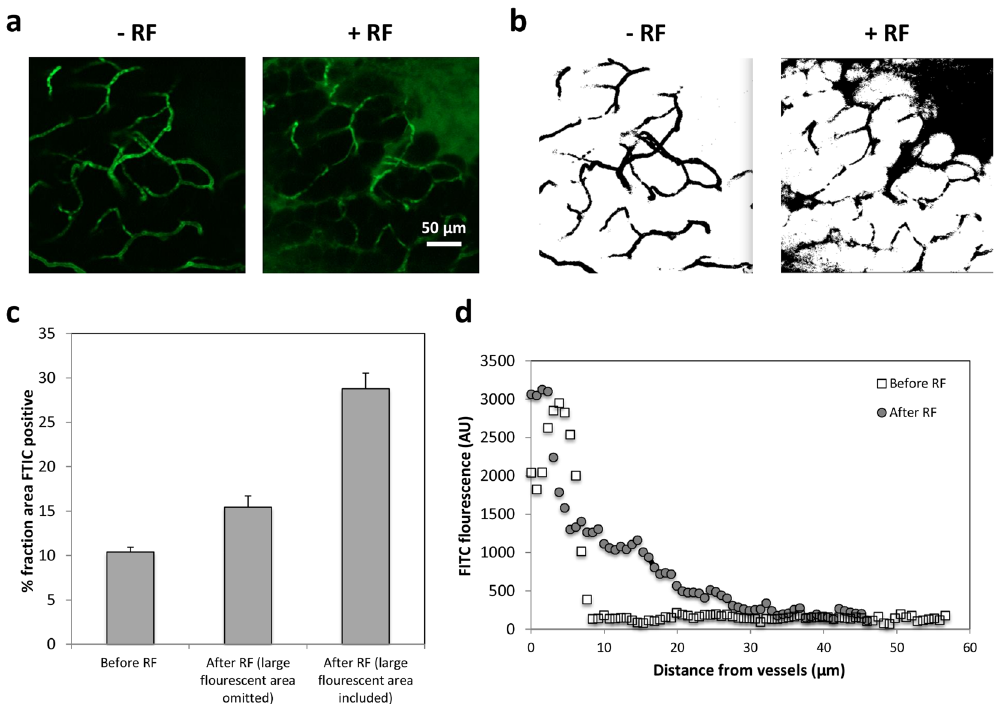
Figure 3. Evaluation of transport in PDAC tumors in mice. ( a ) Representative intravital microscopy images of FITC penetration in tumor tissue following systemic administration before and after RF exposure. ( b ) Sample image analysis to quantify percent area fraction of FITC-positive regions with and without RF, highlighting a large region in the upper right corner (with RF). ( c ) Fraction of tissue area stained for FITC. ( d ) Quantification of distance of FITC-positive regions from the surrounding